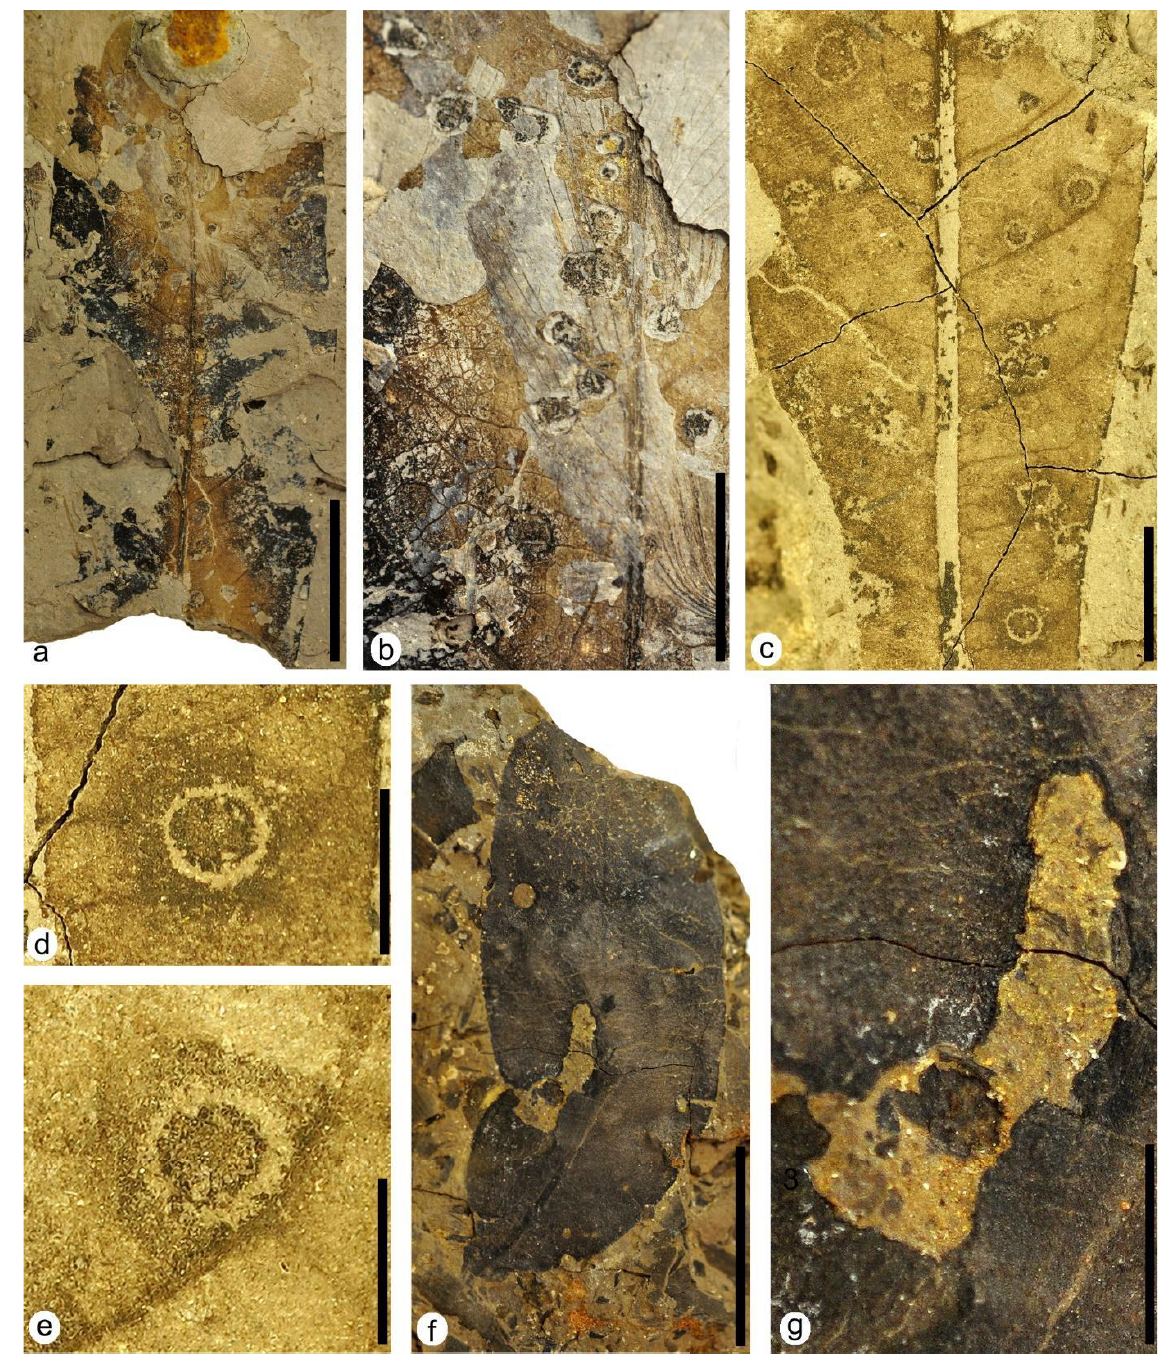
Figure 9. Plant–insect interactions on leaves of both the terrestrial Angiosperm Type 1 (photos a – e ) and Angiosperm Type 2 (photos f , g ). ( a ) MAP-8371, a highly degraded apical part of a leaf with galling DT62. ( b ) Detail of the upper right part of MAP-8371 from photo ( a ) with galling DT62 showing several galls bearing pockmarked to convoluted pustules disposed in chains in their interior. ( c ) Detail of the central area of MAP-8365 from Figure 6f with galling DT120 showing several galls on the lamina. ( d , e ) Details of two of the galls with galling DT120 from photo ( c ) showing the dark-colored patch around the light-colored inner circle. ( f ) MAP-8372, a nearly complete leaf of Angiosperm Type 2 with hole feeding DT01 and DT02 and margin feeding DT15. ( g ) Detail of the central left part of MAP-8372 from photo ( f ) showing margin feeding DT15. Scale bars: ( a , f ) = 2 cm; ( b , c , g ) = 1 cm; ( d ) = 5mm; ( e ) = 3